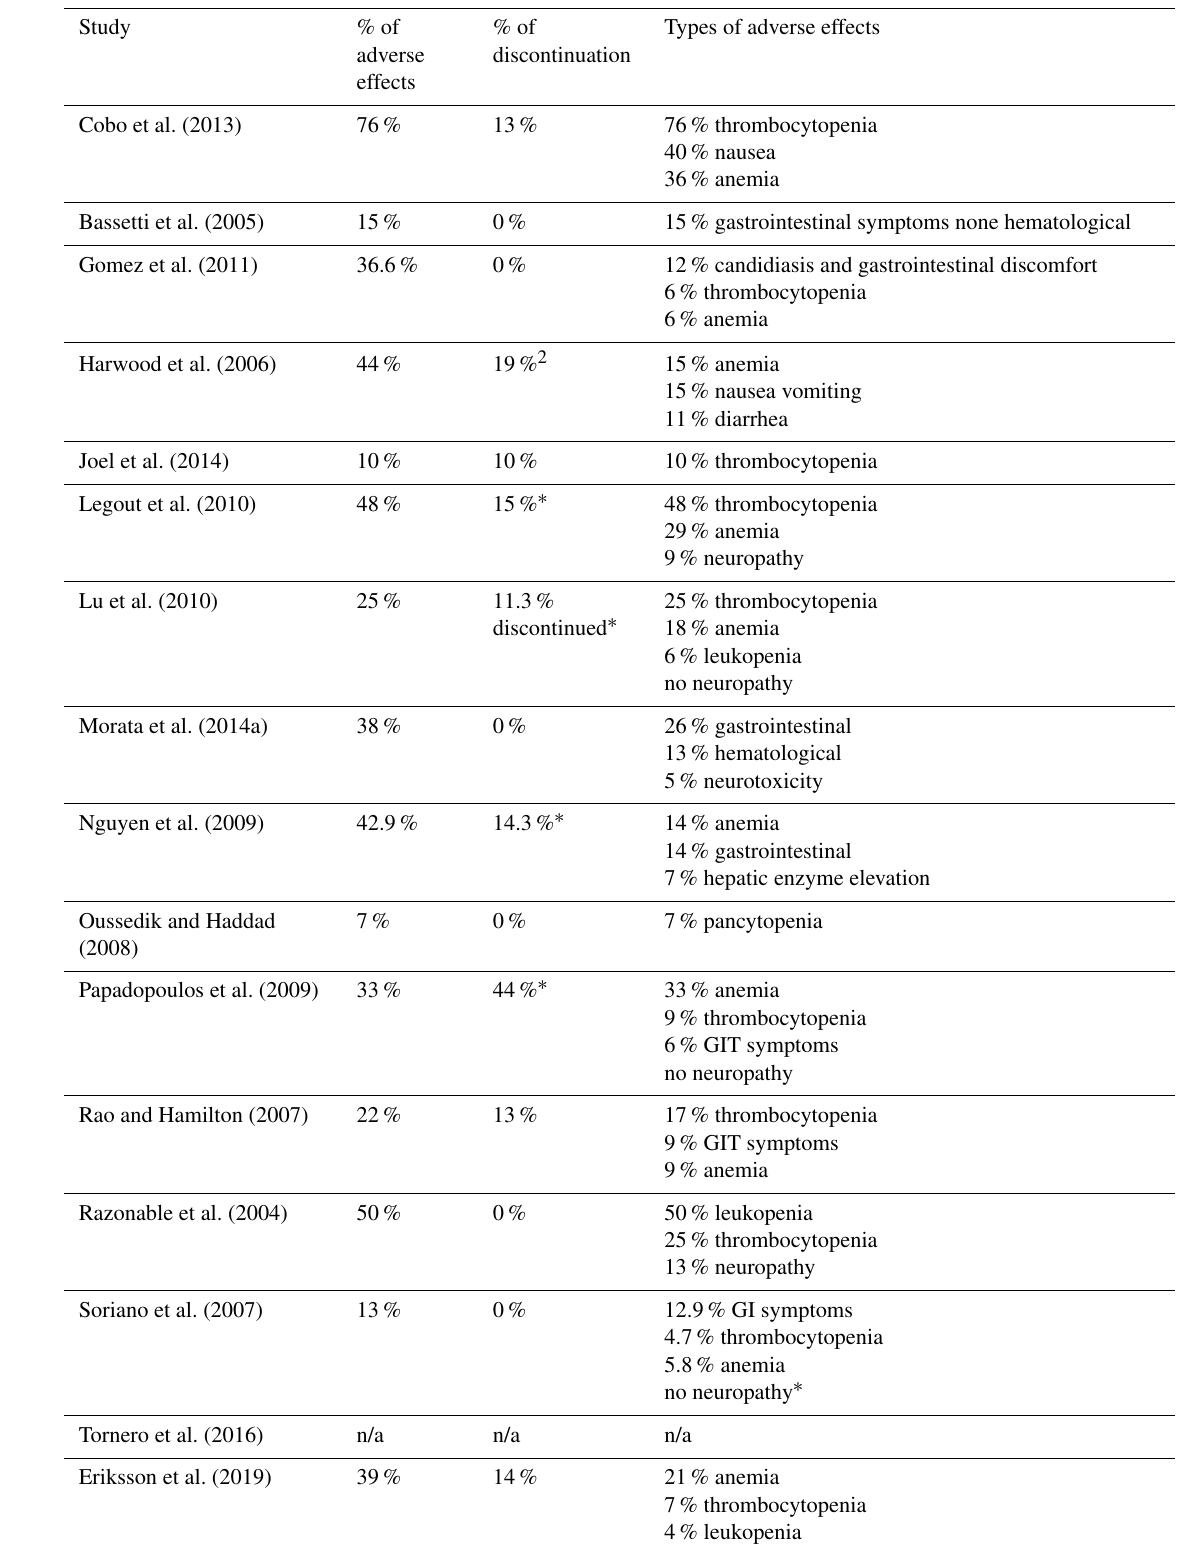
Table 3. Adverse effects